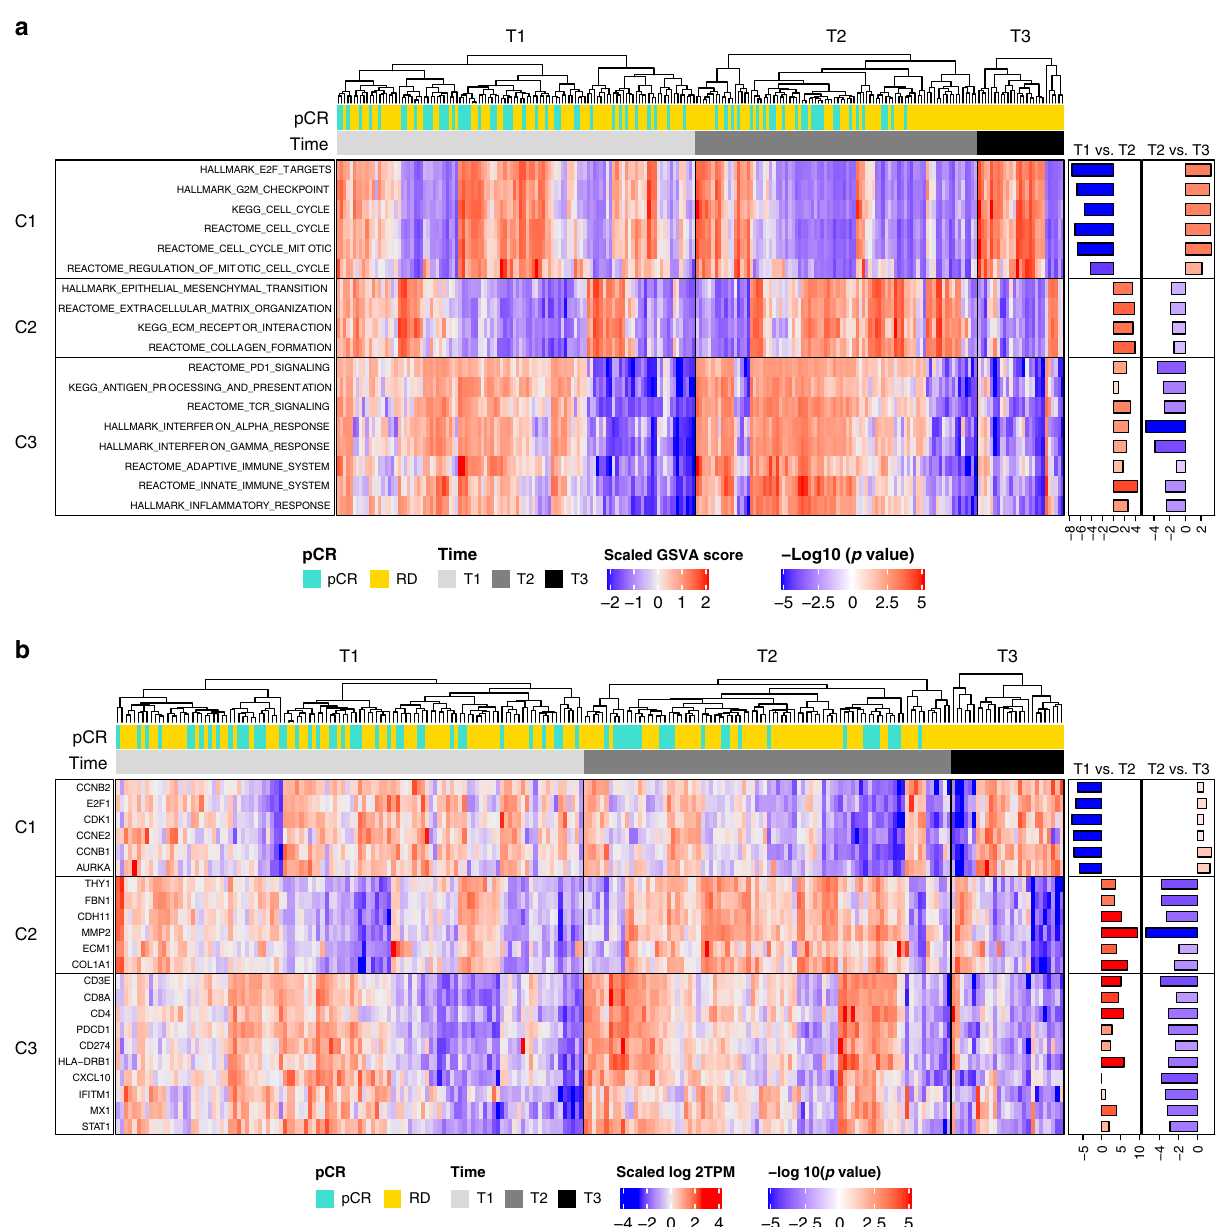
Fig. 2 Differential expression patterns across treatment times. Expression patterns of representative pathways ( a ) and genes ( b ) mapped to the three DE gene clusters. GSVA scores in a were centered and scaled to z -scores for each pathway geneset. Statistical signi fi cance of DE was determined using linear mixed-effects regression analysis (LMER) and shown as sign* − log10( p -value) based on the sign of the t -statistics. Source data are provided as a Source Data fi